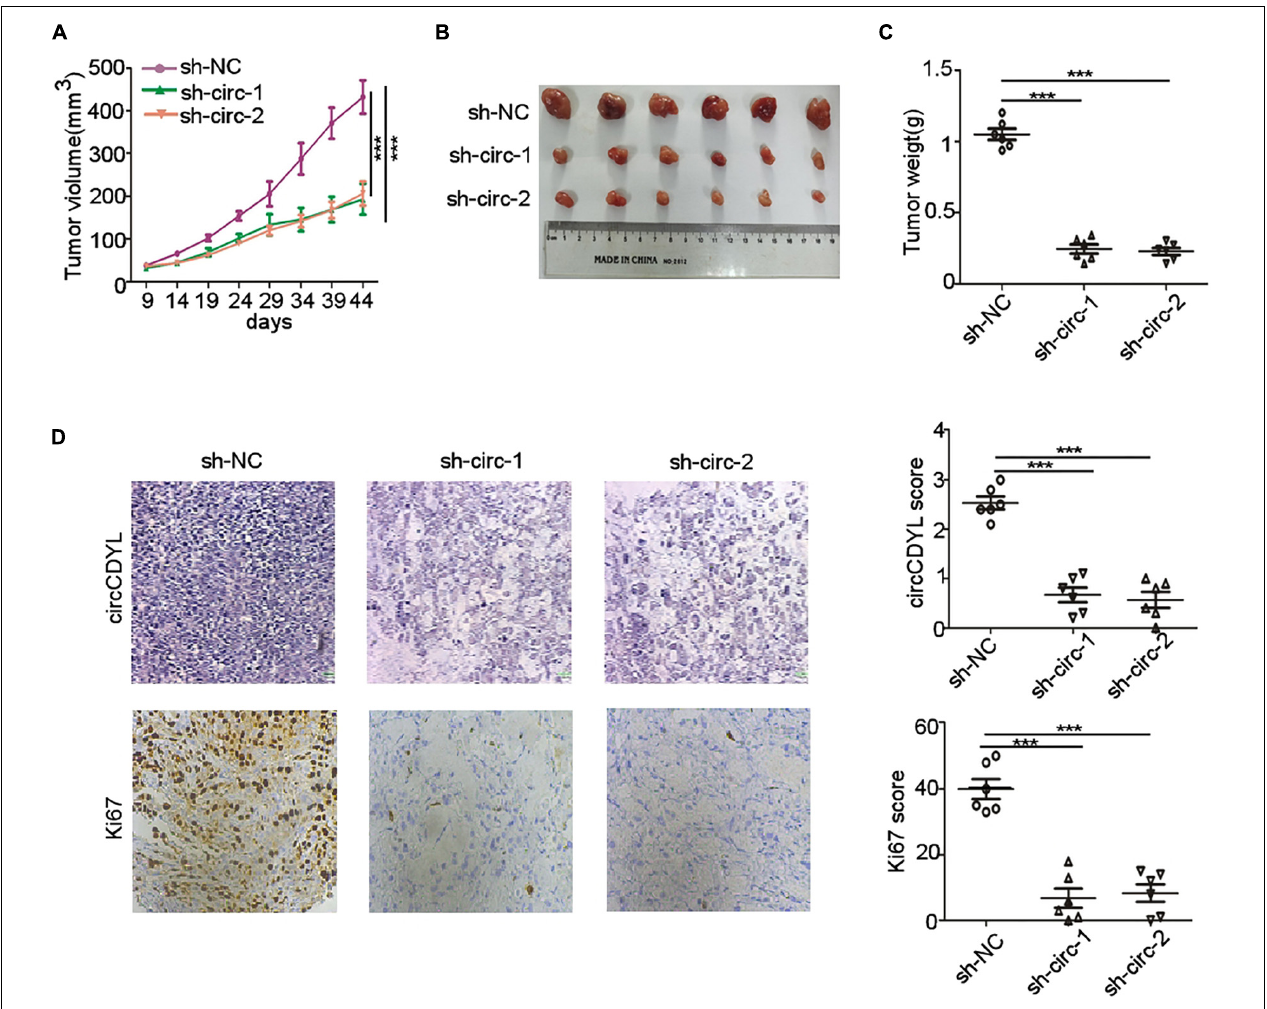
FIGURE 3 | circCDYL promotes progression of HER2 + BC in vivo . (A) Tumor volume derived from SK-BR-3 cells in Balb/c nude mice was measured at various time point. (B,C) . Tumor size (B) and tumor weight (C) was measured after tumor excision. (D) . ISH detection of circCDYL and IHC staining of Ki-67 in tumors tissues. Scale bar 50 µ m. *** P < 0.005. Error bars indicate